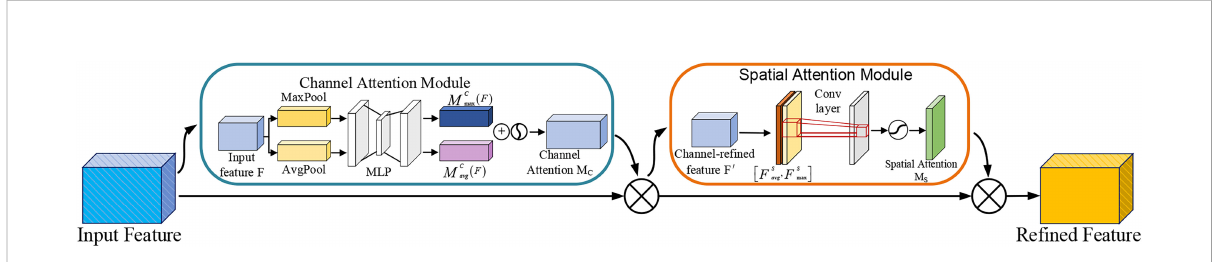
FIGURE 7 The overall structure of convolutional block attention module: MaxPool represents the maximum global pooling; AvgPool represents global average pooling; MLP represents a multi-layer perceptron with shared weights; Conv indicates convolution operation.